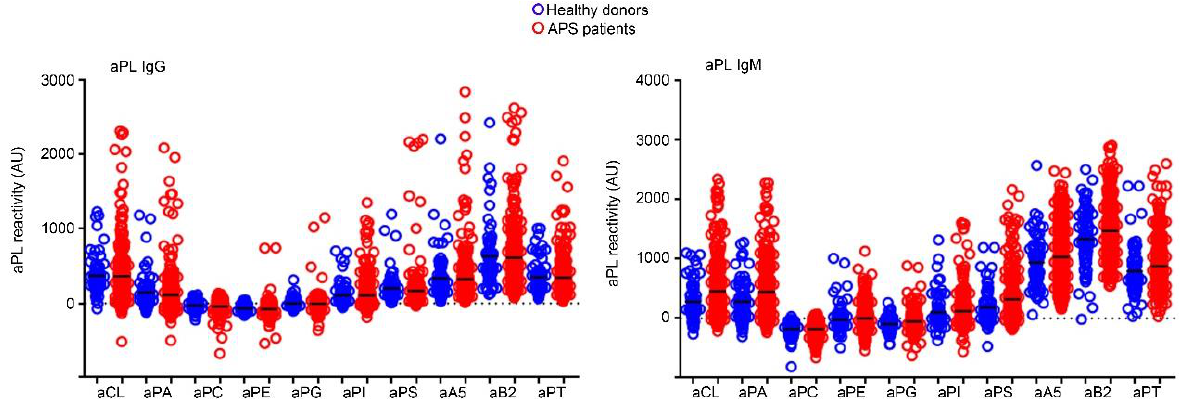
Figure 1. Antiphospholipid antibody (aPL) levels in sera of healthy individuals (blue dots) and antiphospholipid syndrome (APS) patients (red dots). Quantification of each aPL was run by densitometry of their respective bands on the strip of line immunoassay (LIA) incubated with anti-human IgG (left graph) or IgM (right graph). Net mean density values are reported as arbitrary units (AU) as indicated in Section 4.3. of Materials and Methods. Dark lines show the mean of each aPL’s reactivity. aCL, anti-cardiolipin; aPA, anti-phosphatidic acid; aPI, anti-phosphatidylinositol; aPC, anti-phosphatidylcholine; aPE, anti-phosphatidylethanolamine; aPG, anti-phosphatidylglycerol; aPS, anti-phosphatidylserine; aB2, anti- β 2-glycoprotein-1; aA5, anti-annexin 5; aPT, anti-prothrombin. Table 2. Percentiles for each antiphospholipid antibody (aPL) assessed by line immunoassay (LIA). aPL IgG aPL